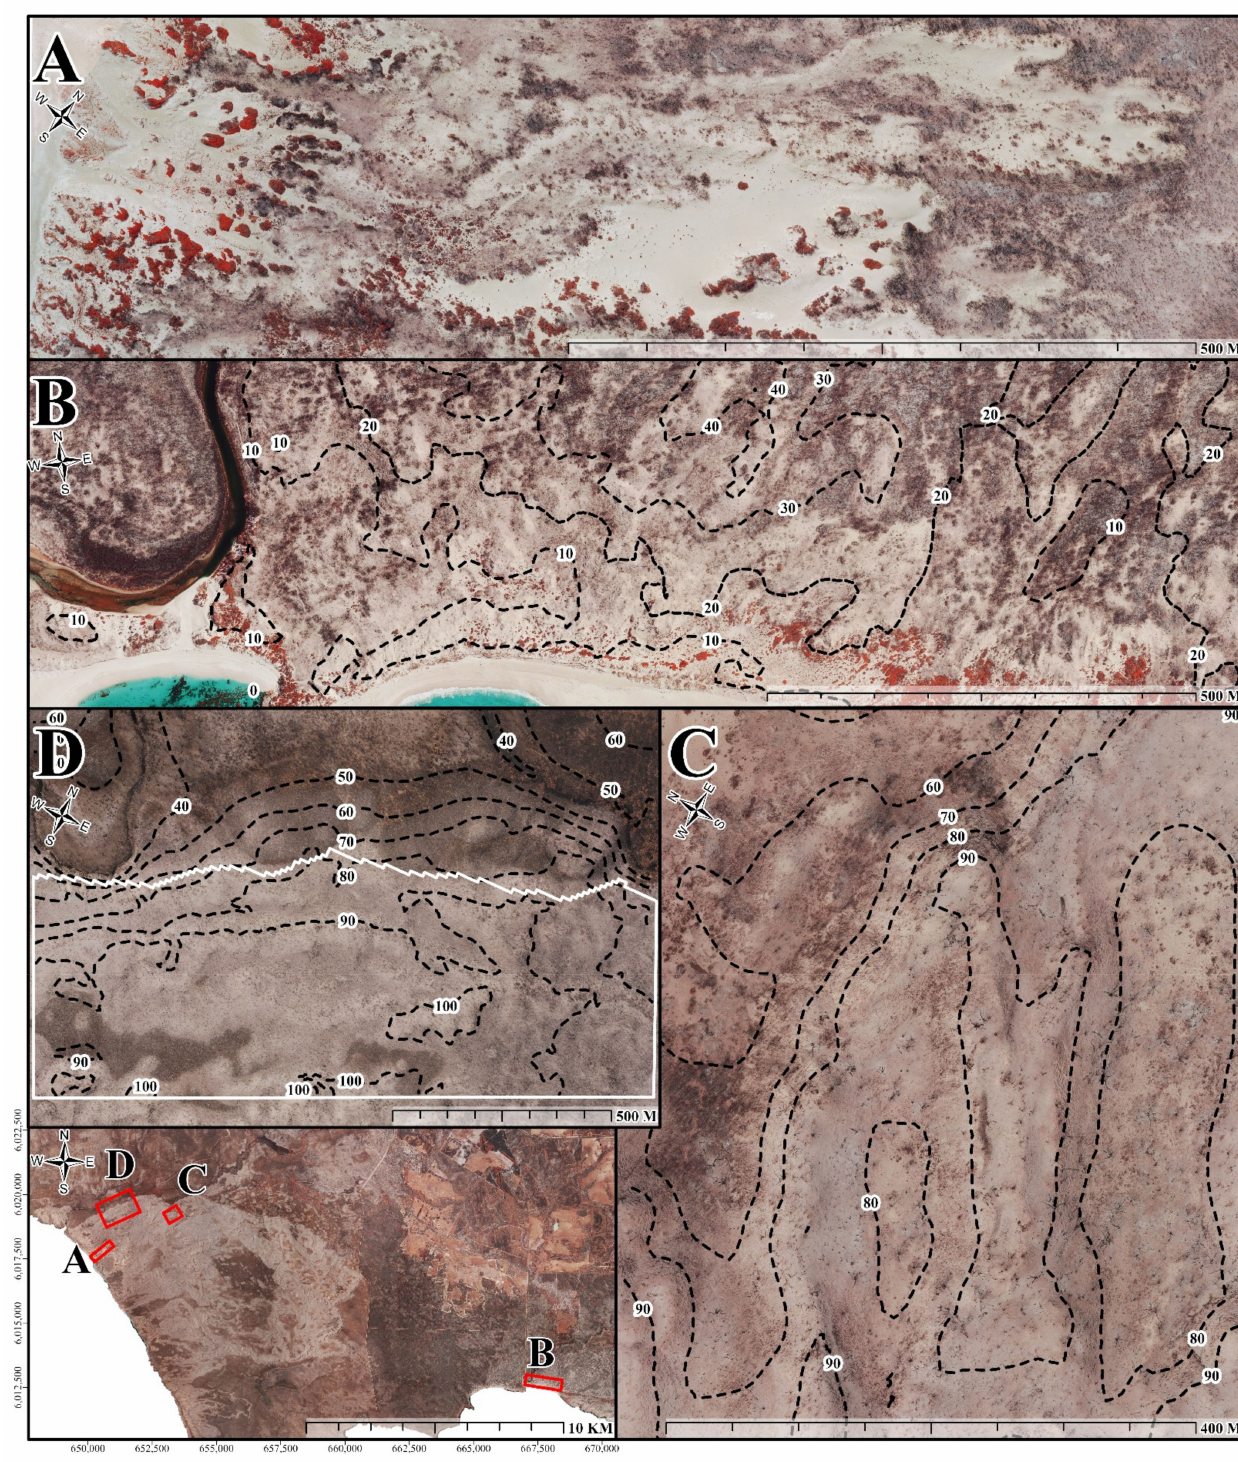
Figure 4. Sites for comparing satellite and aerial-derived burn indices. Aerial imagery is from 30 January 2020 and is displayed in colour infrared. Sites ( A – D ) are described in Table 3 and extent of analysis area is shown in Figure 2. Site D has a mask outline (white) based on the soil boundary between Holocene dune (CDC) in the southern portion and Pleistocene lowlands in the northern section (GD and LP Table 1). Interactive perspective web map of locations can be viewed at this https://arcg.is/0j1T450, accessed on 22 November 2021. Black dotted lines show 10m